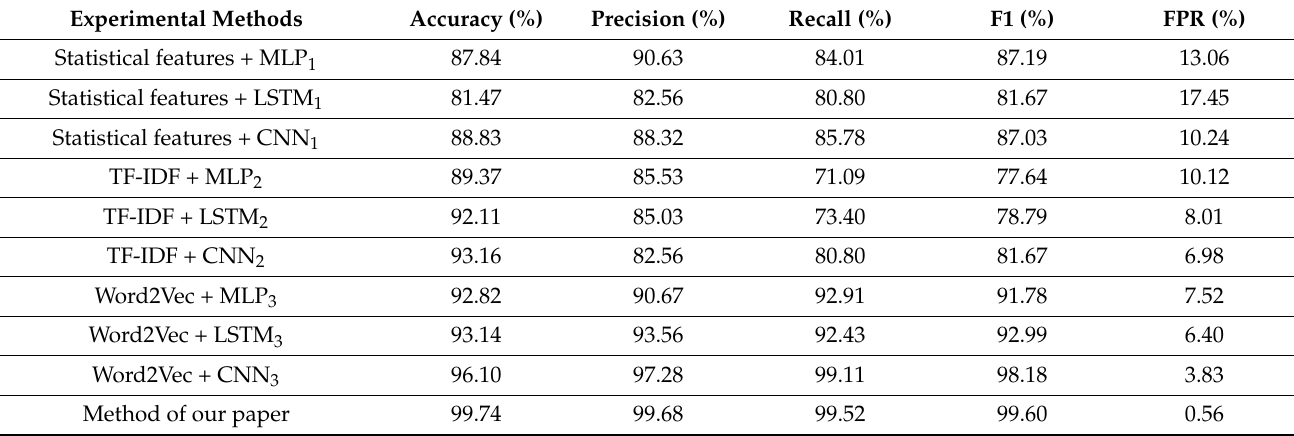
Table 7. The experimental